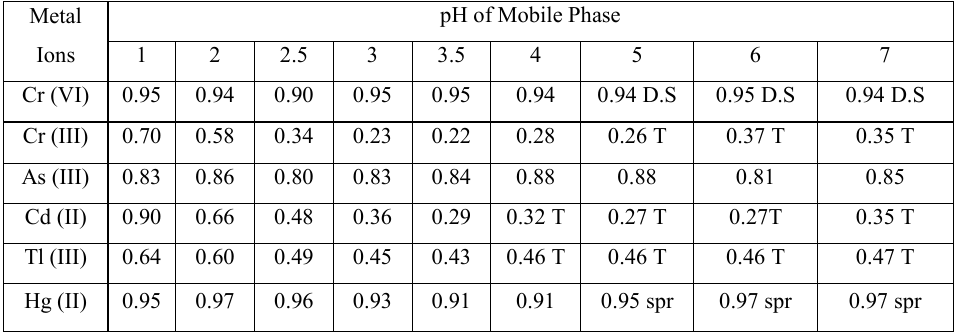
Table 2. Effect of